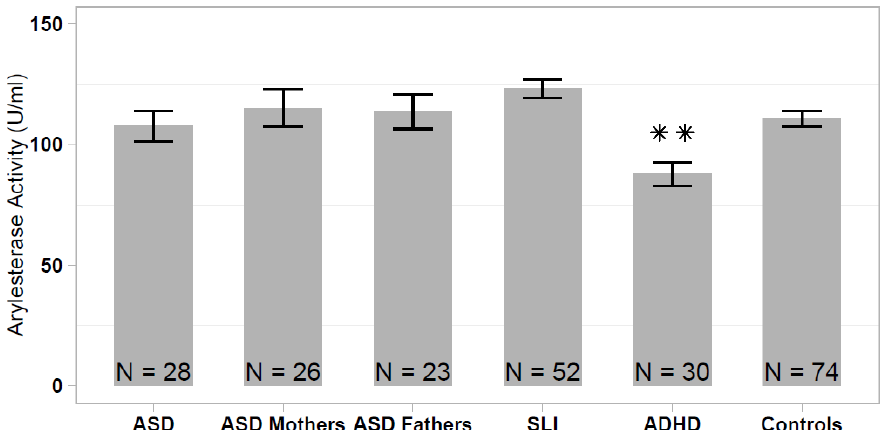
Figure 1. Serum arylesterase activity levels in patients with autism spectrum disorder (ASD), ASD patients’ parents, specific language impairment (SLI), attention deficit/hyperactivity disorder (ADHD), and healthy controls. Data are reported as mean ± standard error of the mean, and significant pairwise comparison between each patient/parent sample and healthy controls are displayed (** p < 0.01).